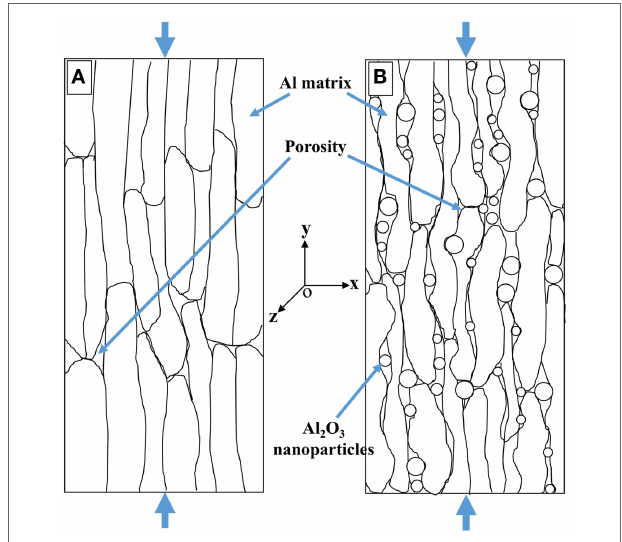
FIGURE 8 | Schematic of microstructure interactions of (A) Al and (B) Al–5%Al 2 O 3